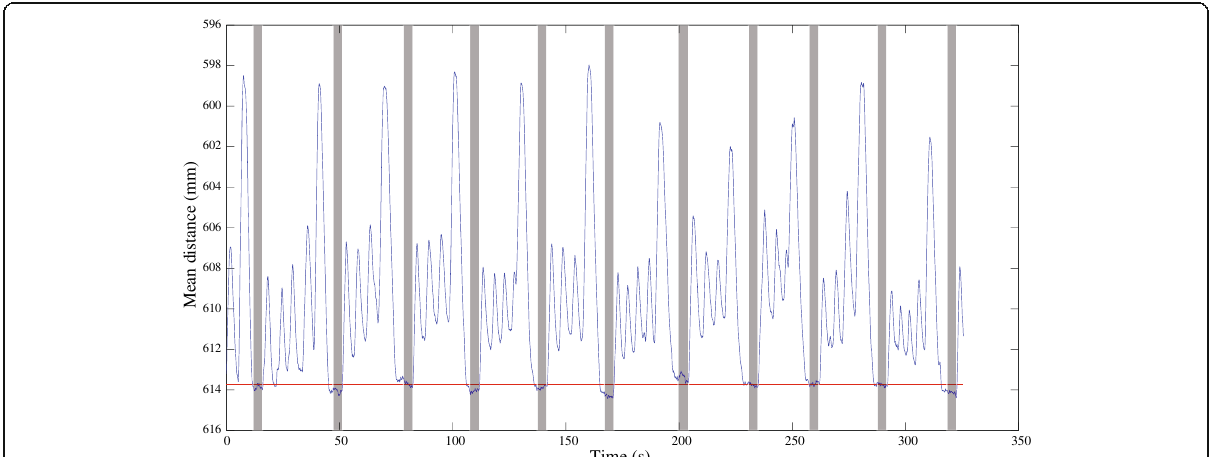
Fig. 8 Respiratory level with feedback. Respiratory level of a volunteer (F4) in the prone position, with visual feedback. Red line is the initial level of breath-hold. Volunteer was asked to return to the same respiratory level every 30 s with the aid of visual biofeedback and maintain breath-hold for a couple of s, indicated by the short horizontal periods